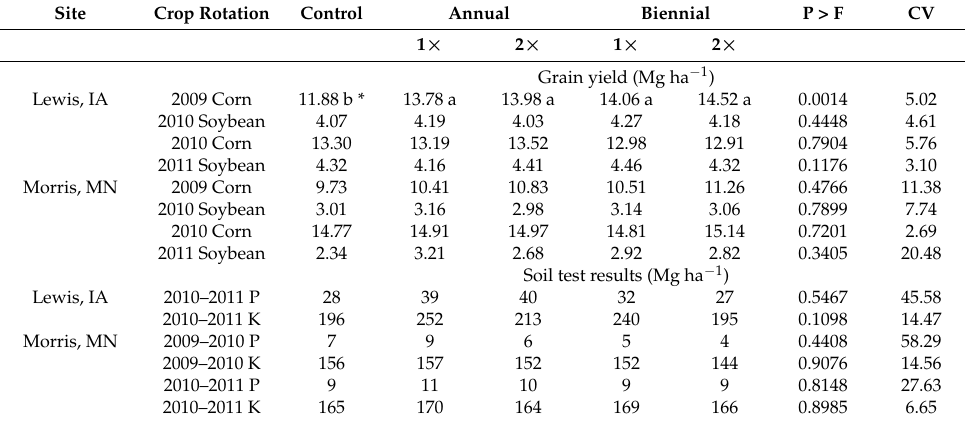
Table 4. Corn and soybean grain yield and soil test results affected by fertilizer treatments at sites with sub-optimal P and above optimal